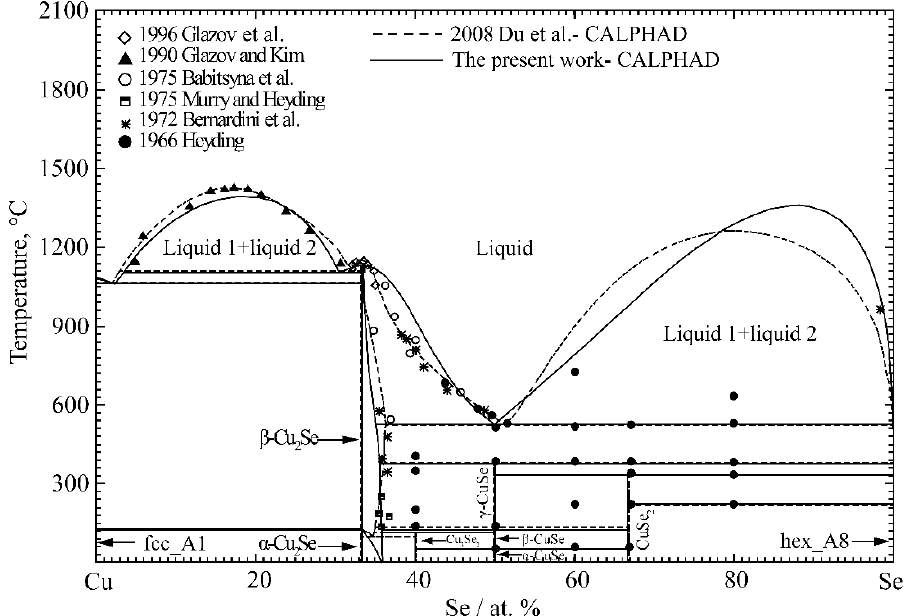
Figure 7. The calculated phase diagram of the Cu-Se system compared with the experimental data from refs. [82–87] and previously optimized results by Du et al. [102]. Table 8. The calculated invariant reactions in the Cu-Se system compared with the experimental data fr om ref. [88] and calculated data from ref. [100].